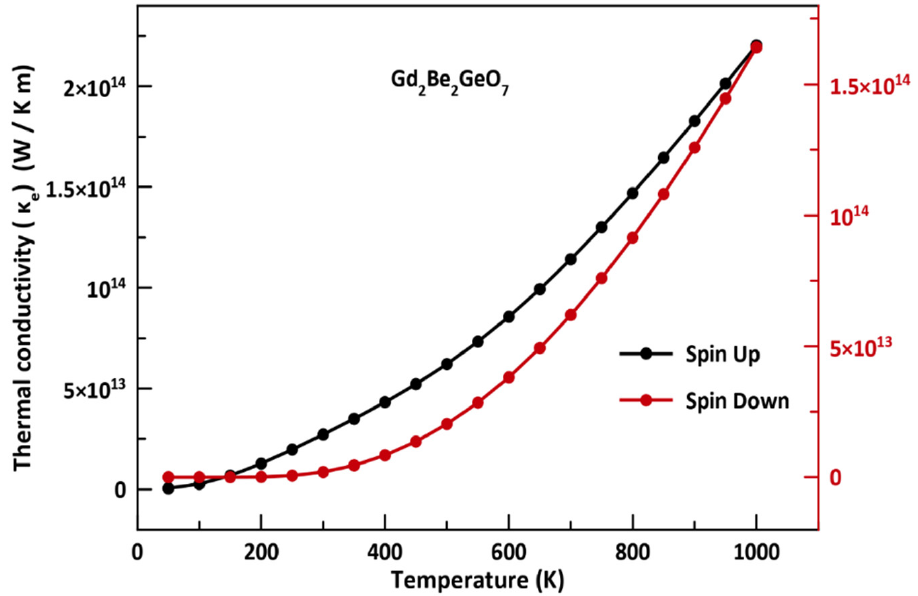
Figure 14. Calculated thermal conductivity κ el / τ as a function of temperature in both spin channels ( up and down ) for Gd 2 Be 2 GeO 7 compound.